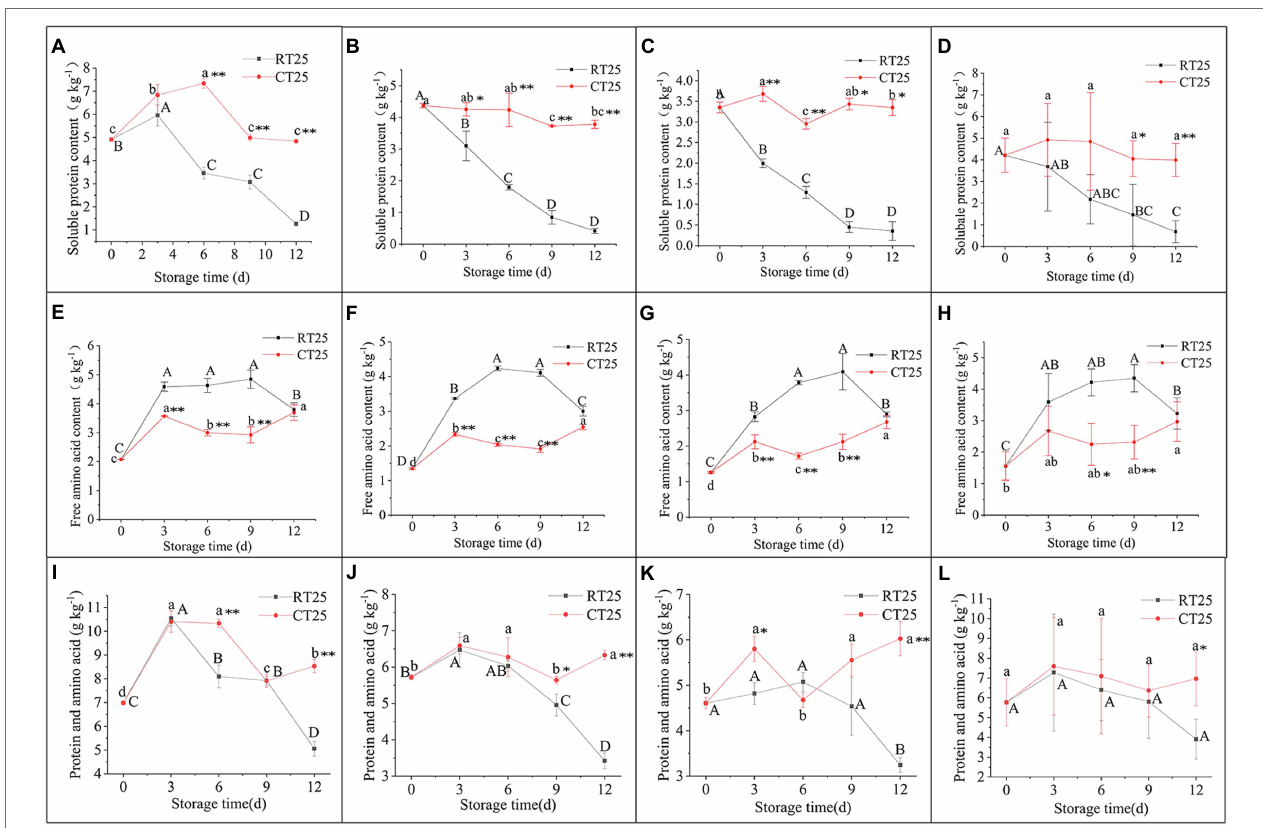
FIGURE 8 | Dynamic changes in soluble protein, free amino acid, and PA (soluble protein and free amino acid) content in shoots stored at 25 ° C and 4 ° C. RT25, bamboo shoots stored at room temperature and analyzed at 25 ° C; CT25, bamboo shoots stored at cold temperature and analyzed at 25 ° C. (A–D) Soluble protein content in shoots during storage for upper (A) , middle (B) , and bottom (C) plant parts, and mean values (D) . (E–H) Free amino acid content in shoots during storage for upper (E) , middle (F) , and bottom (G) plant parts, and mean values (H) . (I–L) PA content in shoots during storage for upper (I) , middle (J) , and bottom (K) plant parts, and mean values (L) . Data are presented as mean ± standard deviation ( n = 3). Significant analysis was performed using the Student’s t -test, in which different letters represent significant difference between treatments within the group, and the asterisk represents the level of significance between groups ( * means the difference is significant at the 0.05 level, ** means the difference is significant at the 0.01